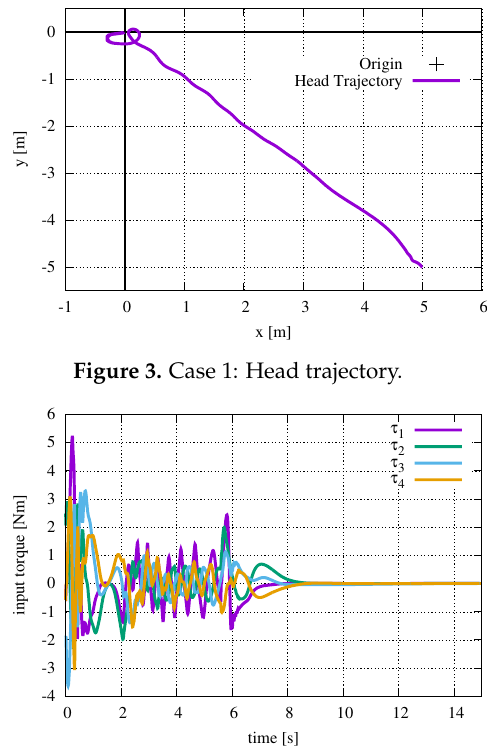
Figure 4. Case 1: Time variation of the input